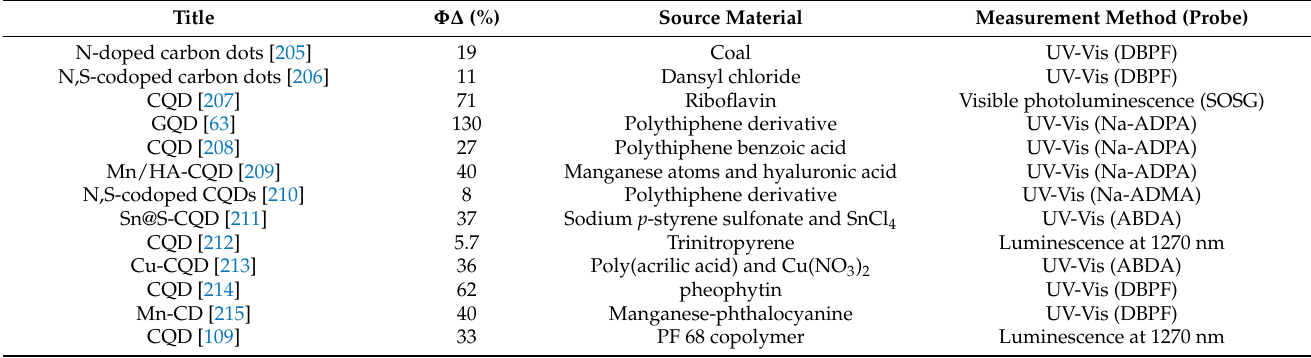
Table 4. Values of singlet oxygen quantum yield for selected